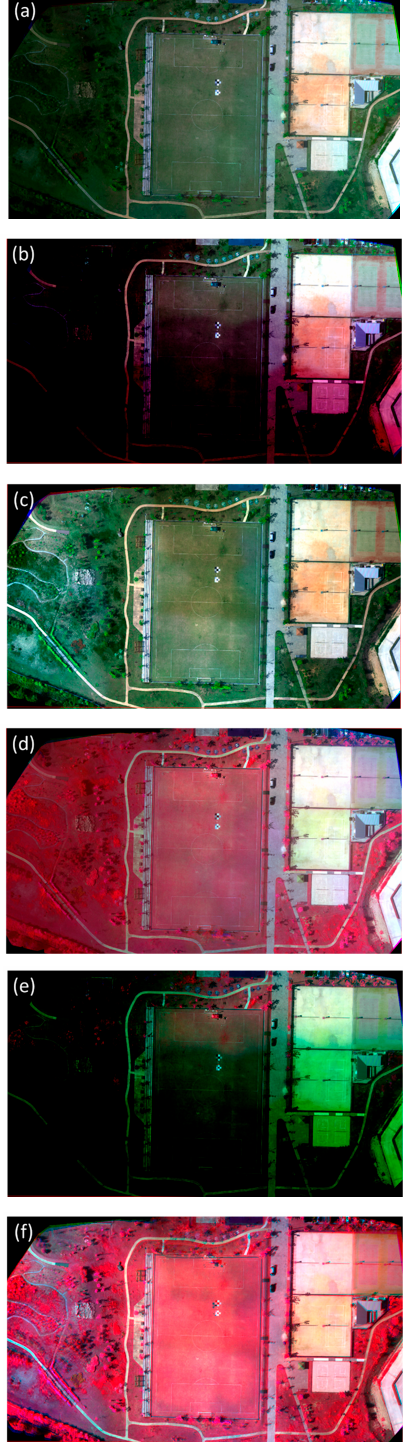
Figure 13. Reflectance map by natural color composites ( a – c ) and pseudo-infrared color composites ( d – f ) from relative calibration by the optimal path (RCOP) (top), relative calibration by acquisition sequence (RCAS) (middle), and no relative calibration (NoRC) (bottom). The results from RCOP had similar color when compared with the validation data using irradiance measurement (Figure 4). The mosaic result was smooth without noticeable color differences at the boundaries between images. The result from RCAS showed good calibration results in the upper part. However, it became darker towards the lower part. The accumulation of errors from the image acquisition sequence seemed severe. Note that for RCOP, optimum paths from all images to the reference image had fewer than five links, whereas for RCAS, a path from an image to the reference increased in the order of acquisition sequence. For relative calibration, the proposed method could provide an efficient path for accumulative radiometric conversion. The results from NoRC indicate that no relative calibration worked better than relative calibration with accumulation sequence. At a glance, it looks similar to the validation data. However, it deserves careful attention. The left side (west side) of the NoRC result is brighter than other areas. The reason is likely changes in camera exposure. The camera was set to adapt exposure automatically which is general setting in application fields. The exposure has changed depending on the amount of light reaching the camera. An exposure value (EV), which is a function of exposure time, International Organization for Standardization (ISO) value, and focal (F) number, can indicate the degree of exposure [40]. When the EV is high, the amount of the exposure is larger, and an image is brighter. The whole mosaicked image was divided into 3×3 subregions (Figure 14) and average EVs for each subregion are listed in Table 3. As shown in the table, EVs of the left subregions are higher than other subregions. The UAV images of some subregions were taken brighter than other subregions. Therefore, the mosaicked image from NoRC on those subregions appears brighter than